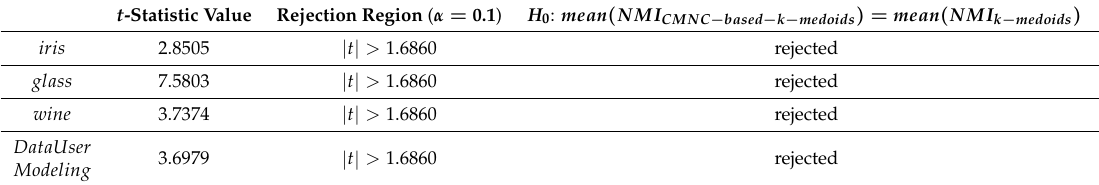
Table 4. Significance test of NMI results: CMNC -based k -medoids vs . k -medoids. t -Statistic Value Rejection Region ( α = 0.1